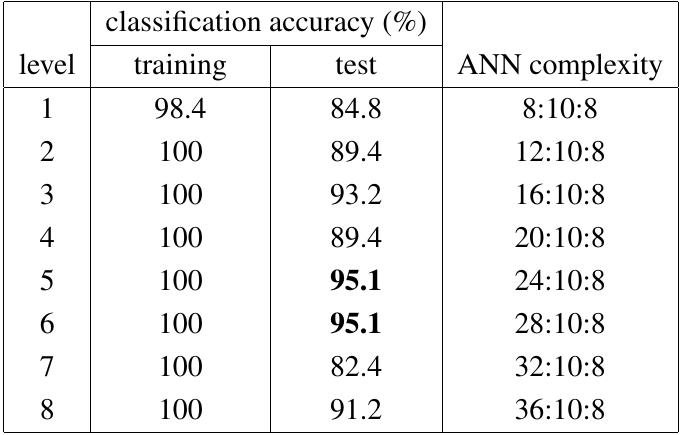
Table 3. Motion classification accuracy with the training and test data, and ANN complexity when the normalized variances and the EDRs of the DWT decomposition coefficients are used as